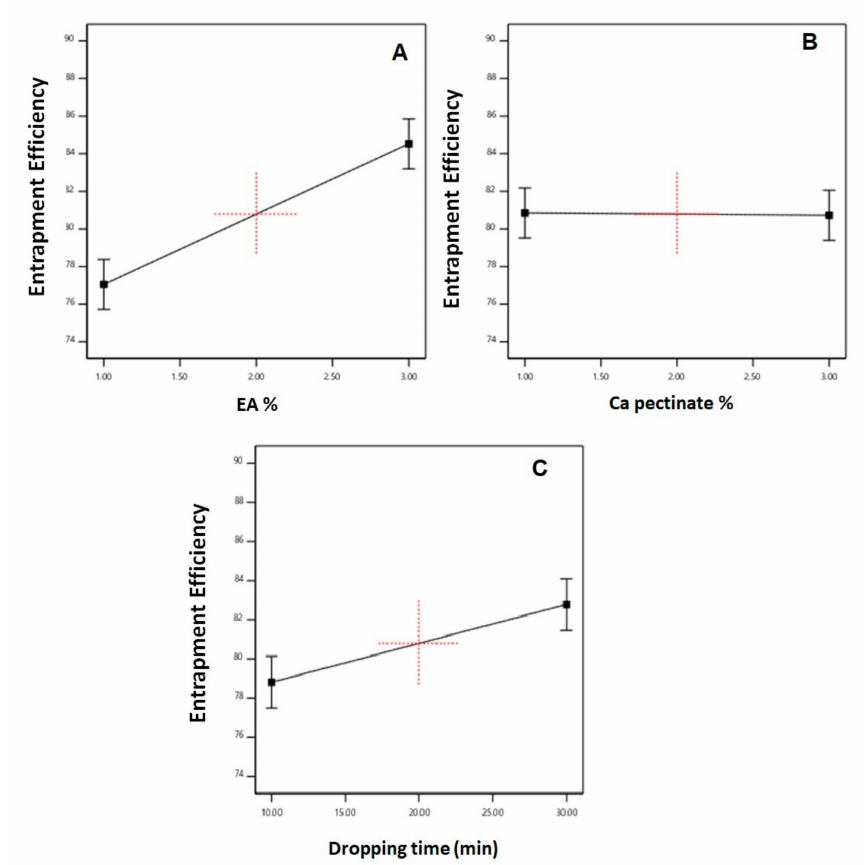
Figure 5. Main e ff ects of ( A ) ellagic acid %; X 1 , ( B ) Ca pectinate %; X 2 , and ( C ) dropping time; X 3 on ellagic acid cumulative percentage released from EA–Ca pectinate floating